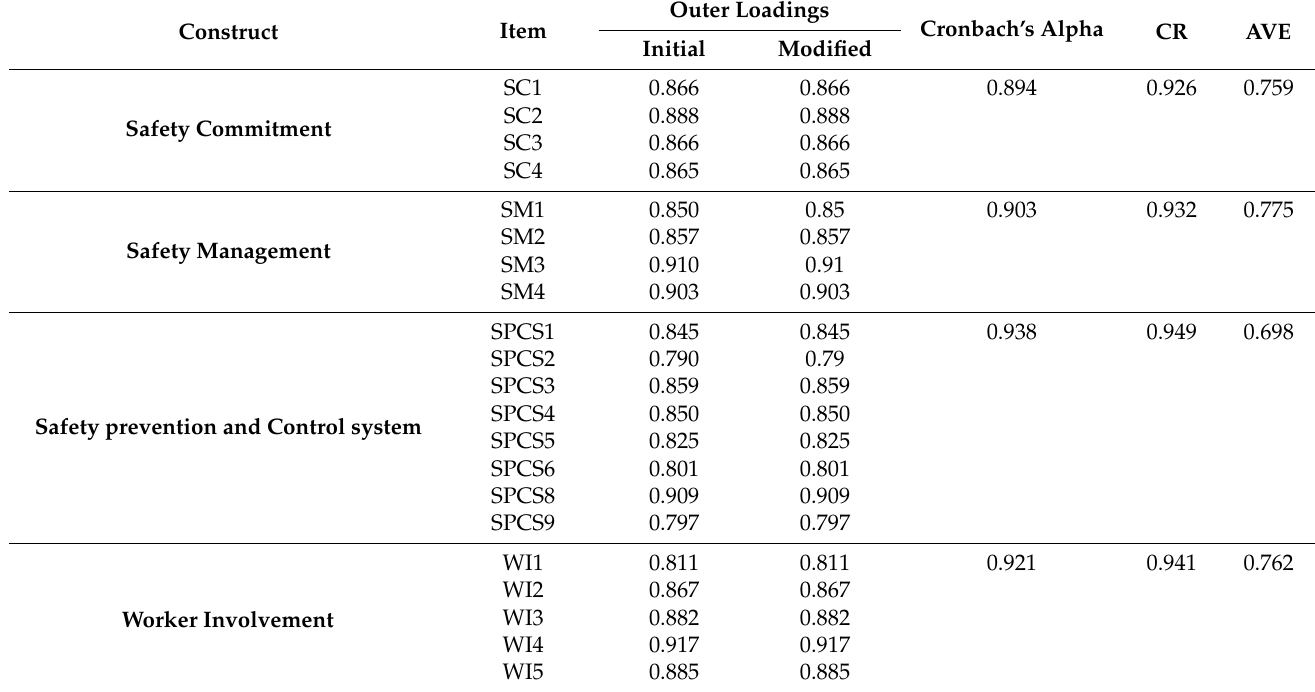
Table 5. Measurement model